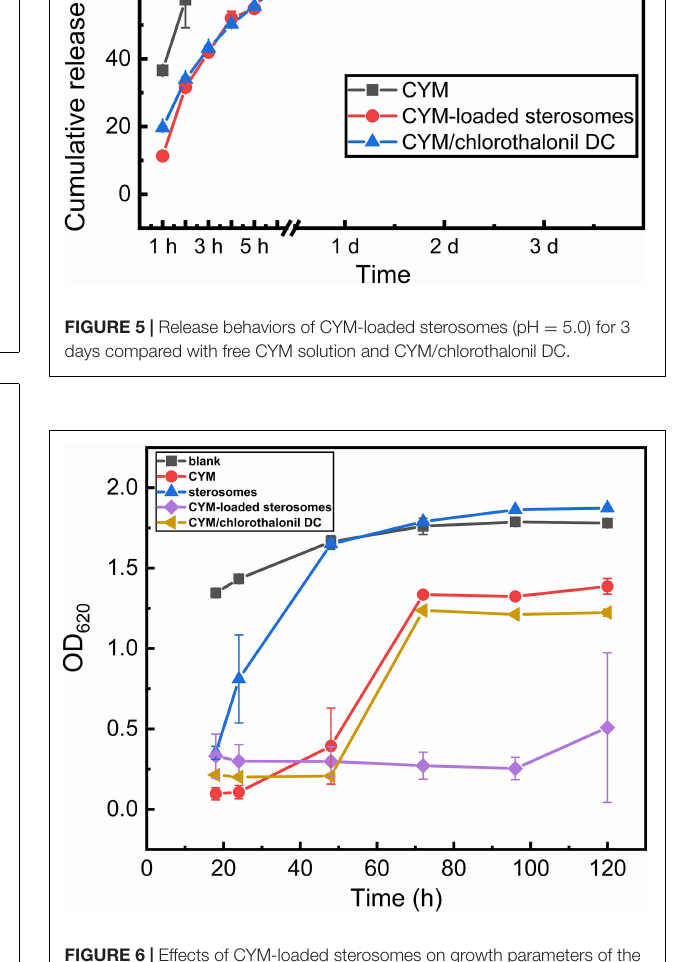
FIGURE 4 | Fourier-transform infrared (FT-IR) spectroscopic spectra of different components of sterosomes and CYM-loaded sterosomes.